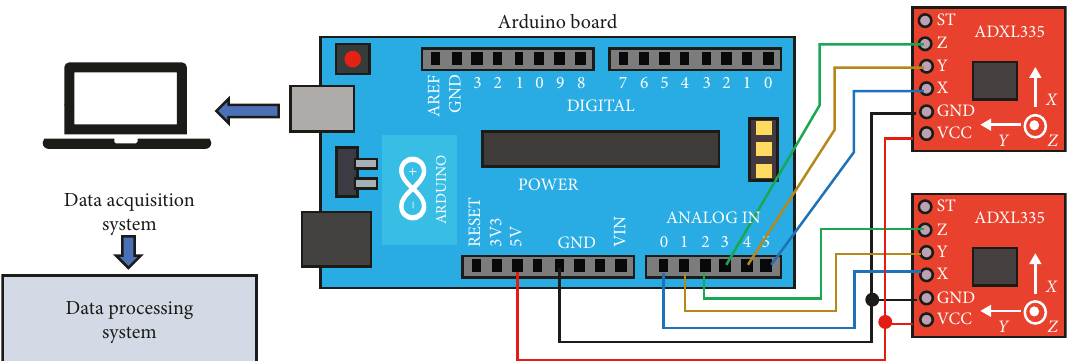
Figure 4: Scheme of measuring equipment with accelerometers.